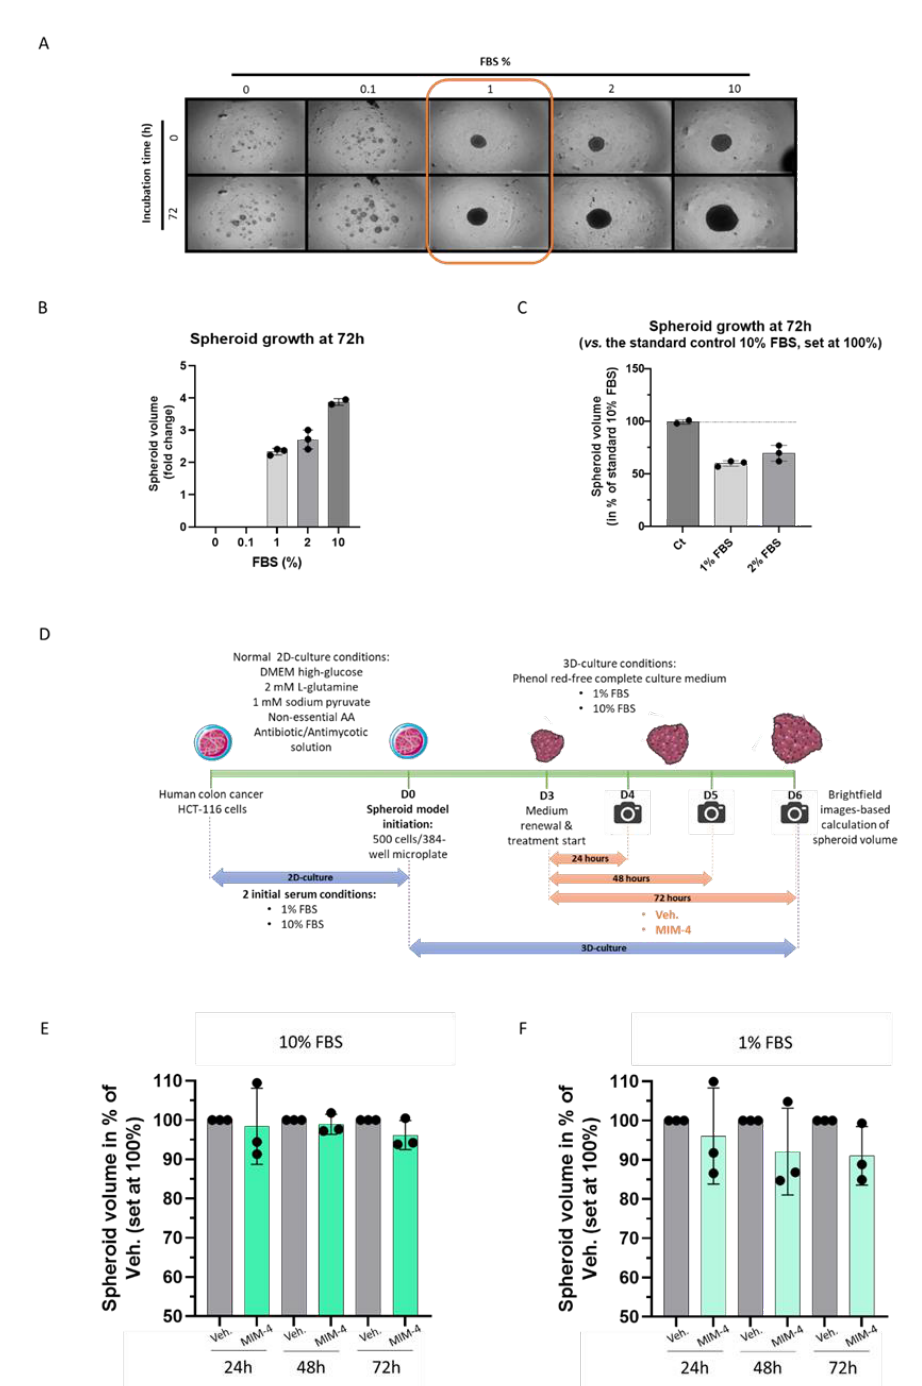
Figure 3. MIM-4 displays slight anti-proliferative effects on HCT-116 colon carcinoma cells cultivated in 3D-spheroids’ model. ( A ) Representative pictures of the spheroid growth regarding the different FBS percentages tested (ranging from 0 to 10% as shown in the legend) at the time of plating and after 72 h. The pictures were taken with an automated digital widefield microscope (BioTek Cytation 5). Three images in brightfield at distinct z-axis were taken with objective 4 × . The orange box highlights the 1% serum concentration that is employed as a starved culture condition for the experiment illustrated and presented in ( D , E ). ( B ) HCT-116-derived spheroid growth after 72 h of incubation in the presence of various FBS% (ranging from 0 to 10% as shown in the graph legend). ( C ) The results are presented as the mean ± SD of spheroid volumes folds at 72 h normalized to the same spheroid volumes at D0, in each tested-condition. Each condition was performed in 3 technical replicates (black dots). ( D ) Scheme of the experimental protocol (E , F ) Effect of MIM-4 on HCT-116- derived spheroid growth, either in 10% or in 1% FBS. The spheroid volume was calculated for each